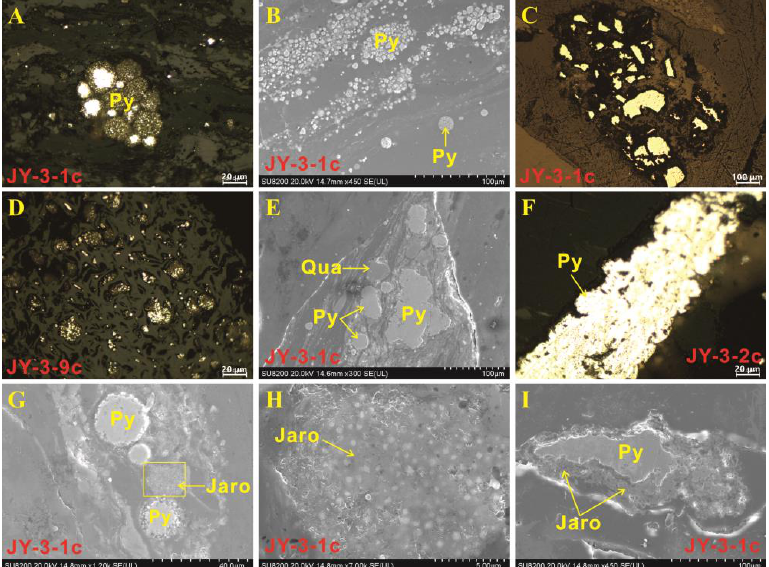
Figure 8. Reflected light optical microscope and SEM secondary electronic images of Pyrite (Py) and jarosite (Jaro) in the Jinyuan Coal. ( A – C ), pyrite framboids and subhedral to euhedral crystals pyrite; ( D ), cell-filling pyrite; ( E ), massive pyrite; ( F ), fracture-filling pyrite; ( G – I ), jarosite, ( H ) is the enlargement of rectangle in ( G ).